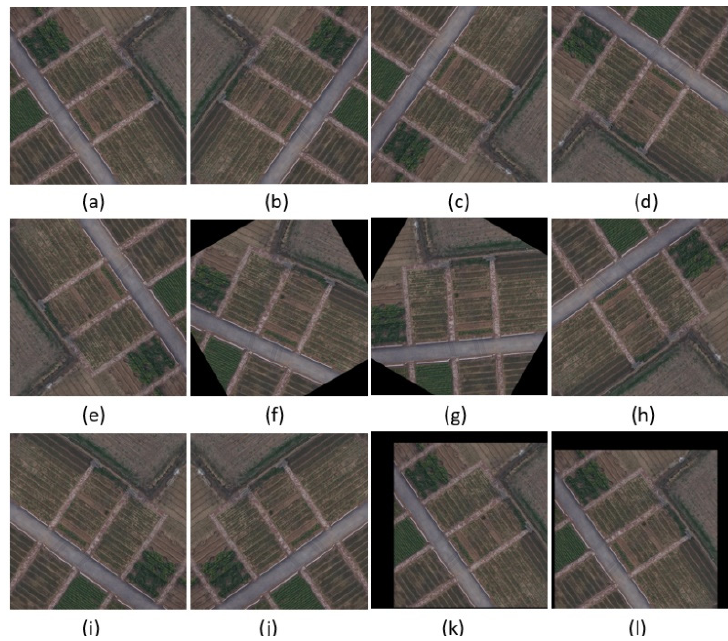
Figure 5. The results of spatial geometric transformation of the label ( a ) original label; ( b ) vertical flip; ( c ) horizontal flip; ( d ) main diagonal rotation; ( e ) sub diagonal transpose; ( f ) 30 degree clockwise rotation; ( g ) 60 degree clockwise rotation; ( h ) 90 degree clockwise rotation; ( i ) 180 degree clockwise rotation; ( j ) 270 degree clockwise rotation; ( k,l ) random shift and scaling (approximately − 10–10%).